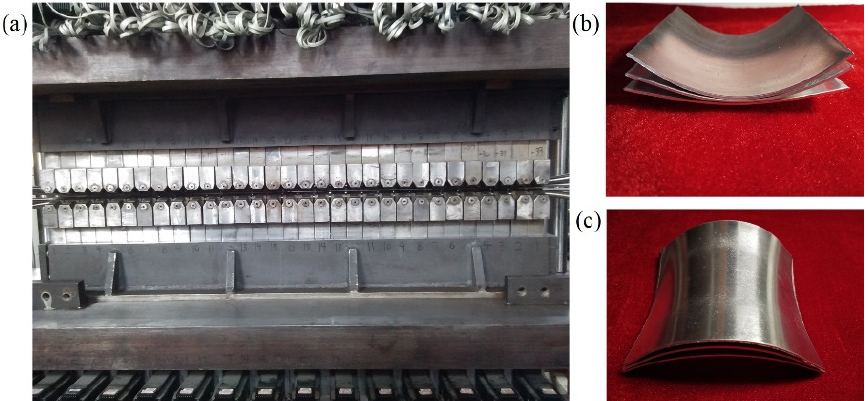
Figure 14. Experimental equipment of CRF and the formed parts: ( a ) Equipment; ( b ) Positive Gaussian curvature parts; ( c ) Negative Gaussian curvature parts.